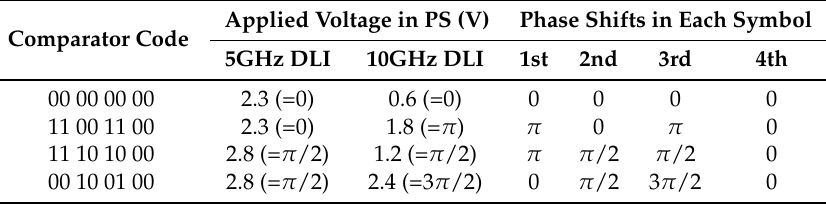
Table 1. The applied voltages of phase shifters against four types of optical comparators. Applied Voltage in PS (V) Phase Shifts in Each Symbol Comparator Code 5GHz DLI